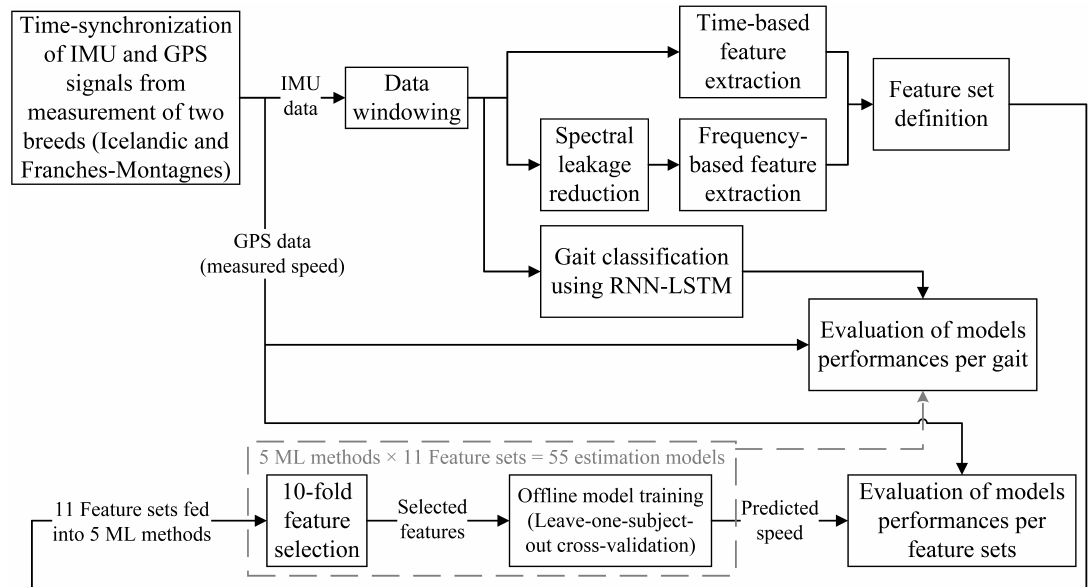
Figure 1. A summary of the model training